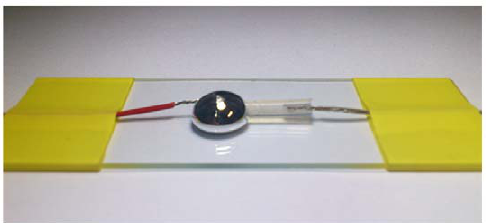
Figure 1. The physiological saline is sealed in a plastic tube. The anode (Pt probe) sticks into the tube and the cathode (Pt probe) into the liquid metal droplet. When the tube and the droplet contact, the polarization voltage emerges and is recorded through the probes.